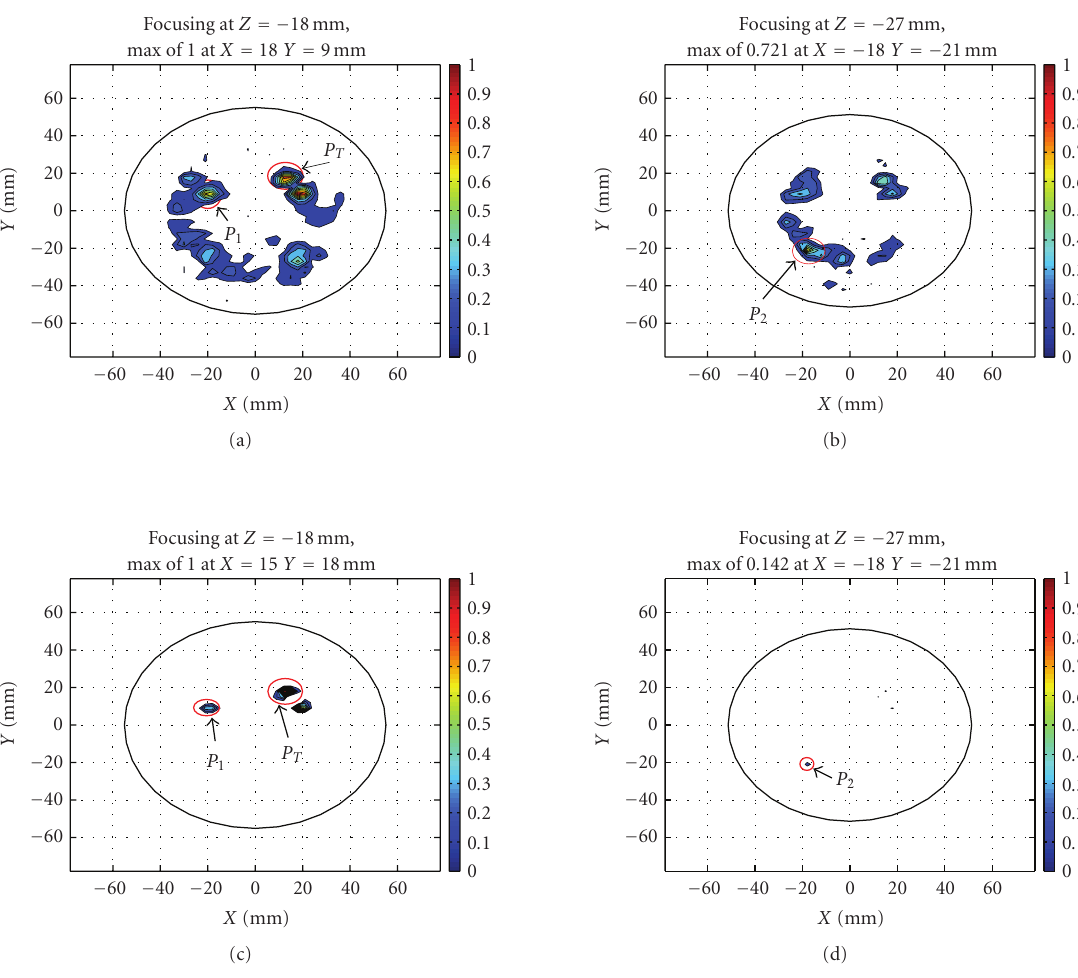
Figure 4: 2D focusing results for standard and improved DAS algorithms, for di ff erent horizontal planes along the z -axis: (a) standard DAS ( z = − 18), (b) standard DAS ( z = − 27), (c) improved DAS ( z = − 18), (d) improved DAS ( z = − 27). 2D contour plots show signal energy on a linear scale, normalised to the maximum in the 3D volume; values below 0.1 are rendered as